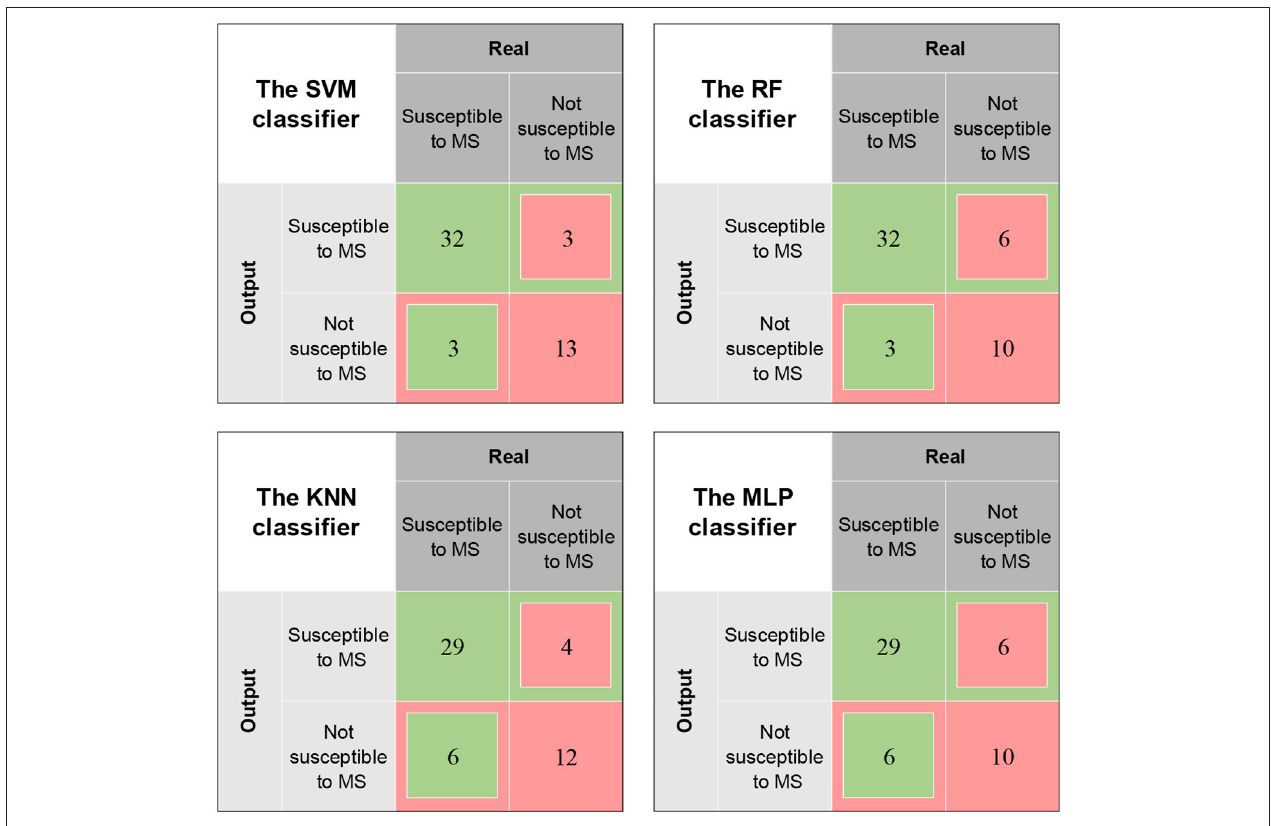
FIGURE 5 | Confusion matrix for the classification results of different classifiers.